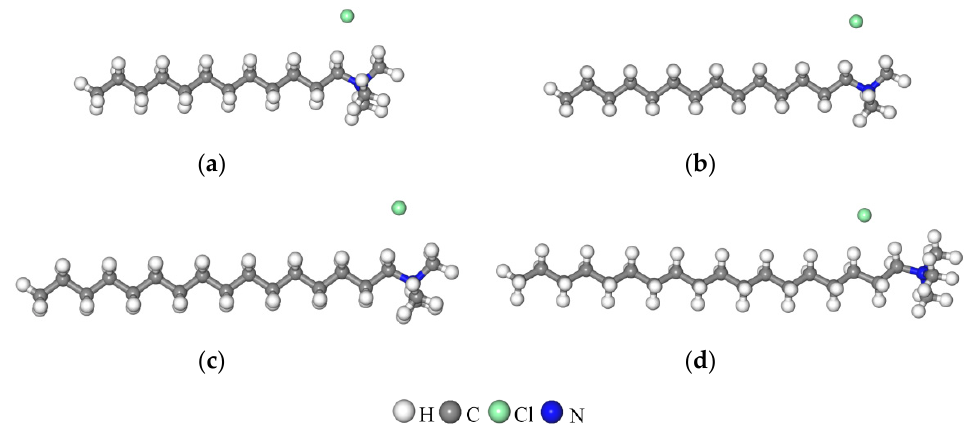
Figure 1. The structure of alkyl ammonium, ( a ) dodecyl trimethyl ammonium chloride (DTAC), ( b ) tetradecyl trimethyl ammonium chloride (TTAC), ( c ) hexadecyl trimethyl ammonium chloride (HTAC), ( d ) octadecyl trimethyl ammonium chloride (OTAC).